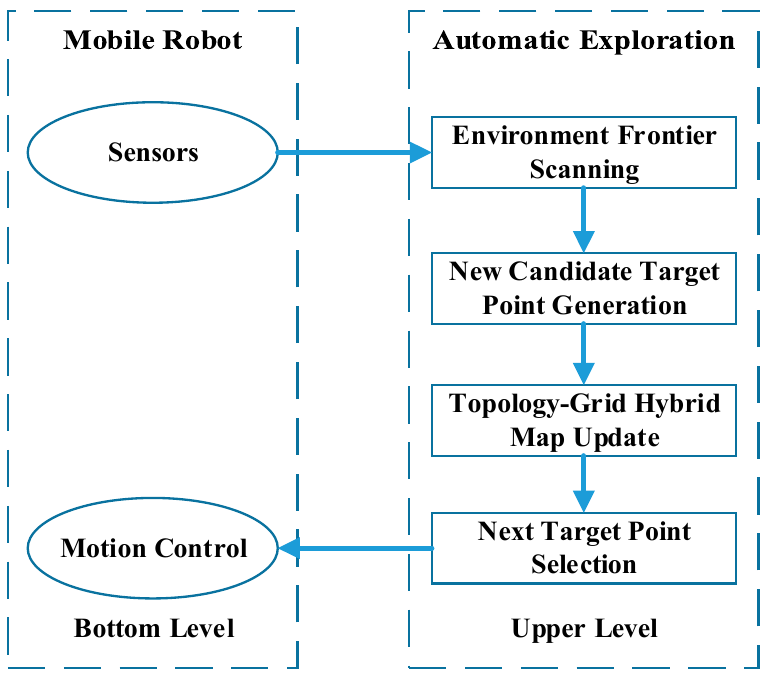
Figure 1. Topology–grid hybrid map (TGHM) algorithm framework.